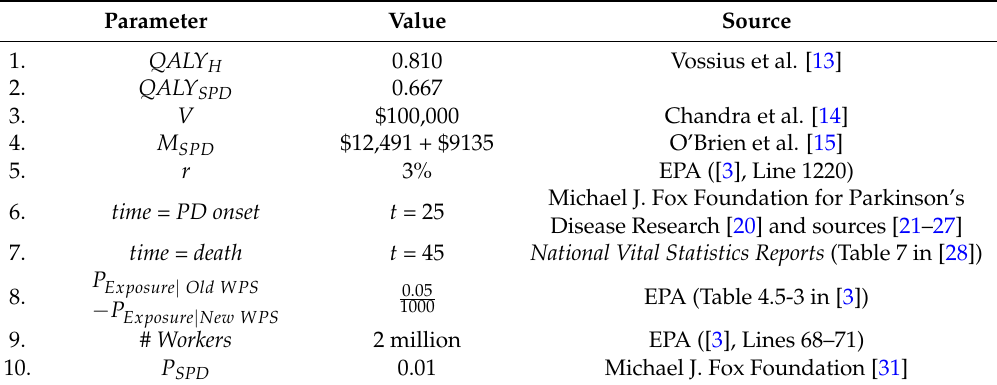
Table 1. Parameters for Total